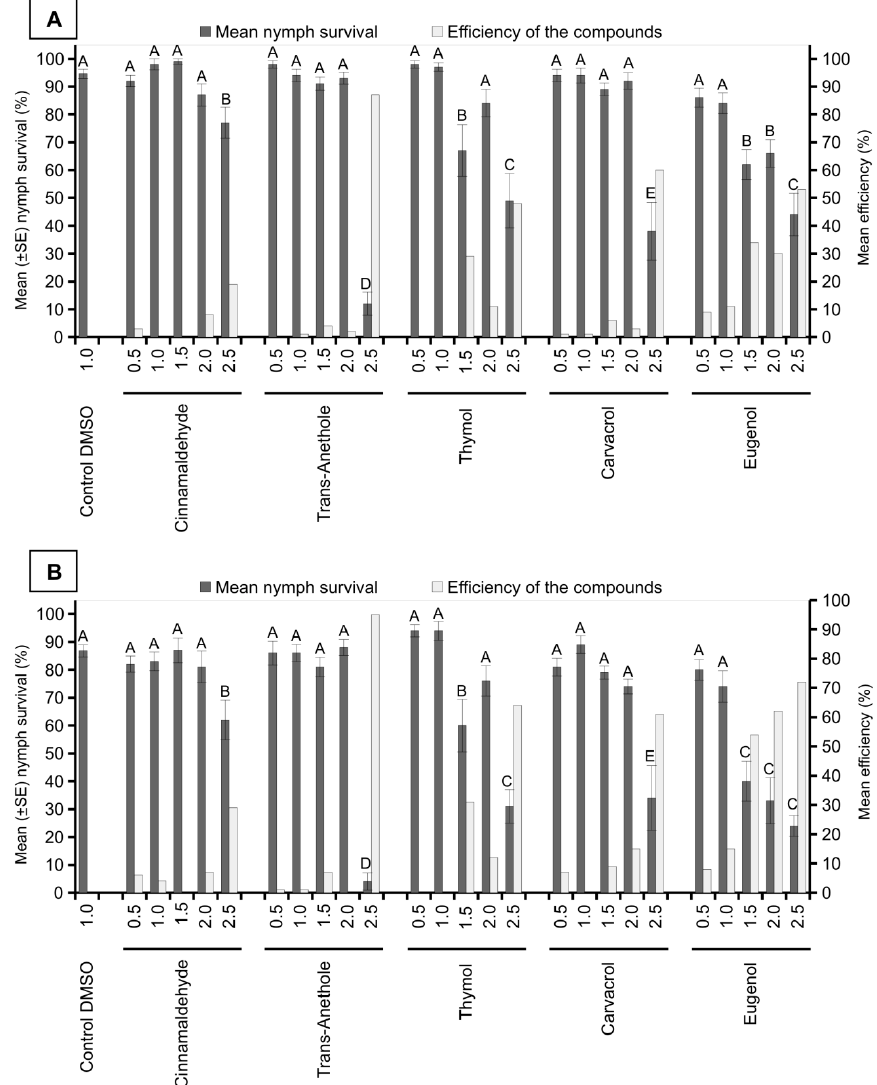
Figure 2. Insecticidal activity of compounds of plant origin (concentrations of 0.5%, 1.0%, 1.5%, 2.0%, and 2.5%) against M. spectabilis nymphs after 24 ( A ) and 48 h ( B ) of application. The control efficiency